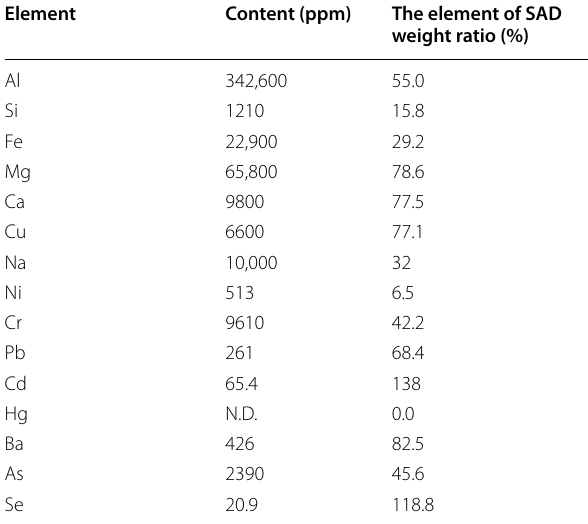
Table 1 Element content of undissolved residue (ppm aluminum dross)